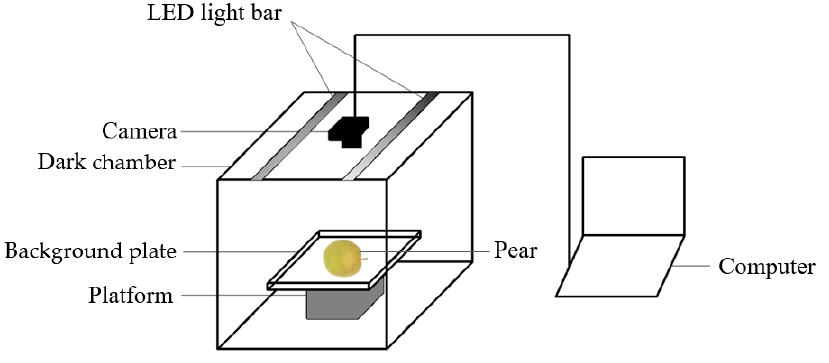
Figure 2. Image acquisition system.